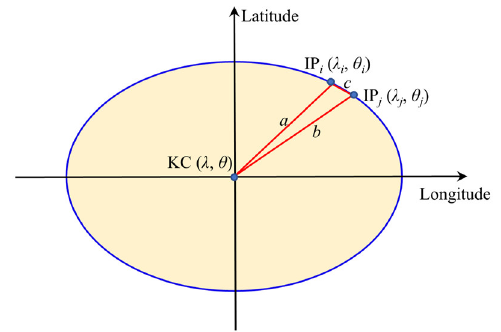
Figure 1. The calculation theory of half-weight polygon area (HWPA) with kernel center (KC) located at ( λ , θ ). The curvature between integral point (IP) i and j is neglected, thus approximating the fan-shaped integral polygon as a triangle. The symbols a , b and c represent the lengths of the three sides of the triangle KC-IP i -IP j .